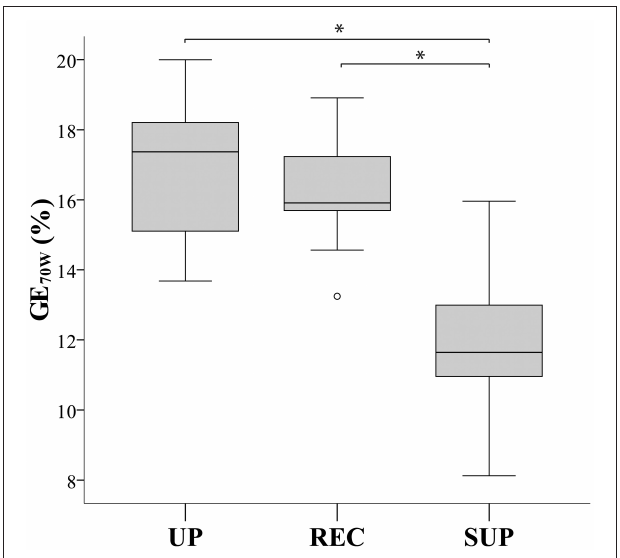
FIGURE 2 | Box plots comparing gross efficiency at 70 Watt (GE 70W ) between cycling postures. UP, upright; REC, recumbent; SUP, supine. *Significant difference ( P ≤ 0.001).